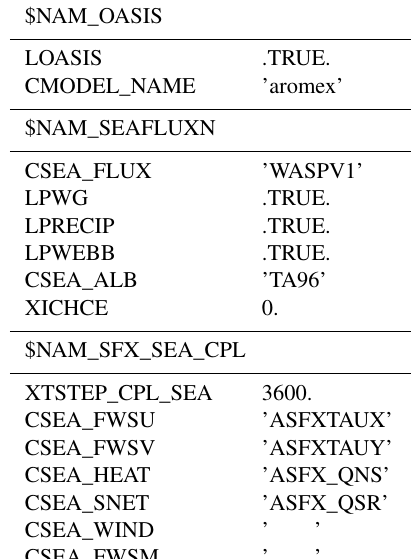
Table A1. SURFEX namelist (EXSEG1.nam) parameters used for coupling (AOW experiment).